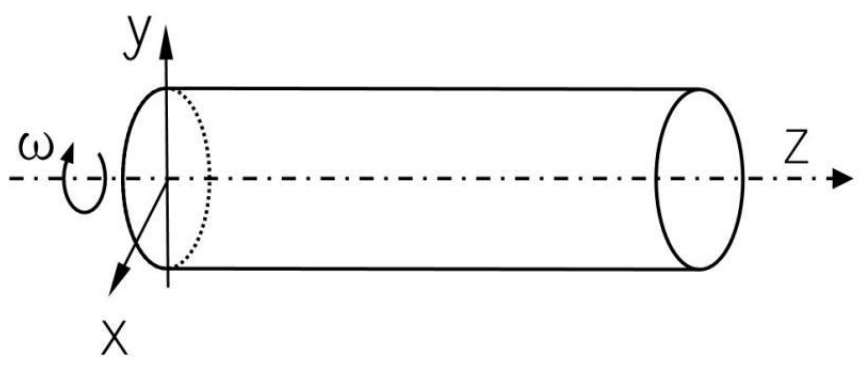
Figure 10. Rotary cantilever structure with Z axis.